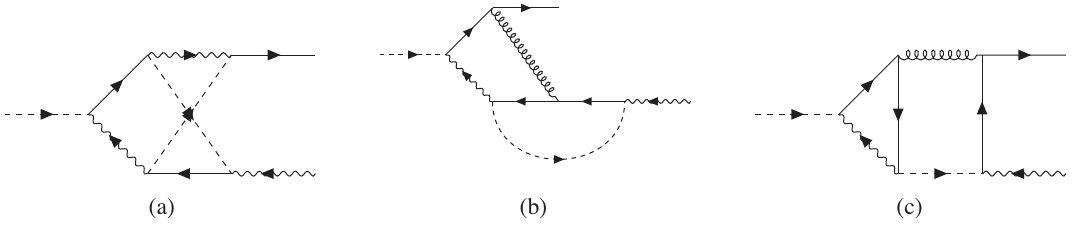
FIG. 12. Two-loop diagrams for vertex corrections to g 0 . In these diagrams, the solid line is for the f propagator, the dashed line is for the ψ propagator, the wavy line is for the b propagator, and the spiral is for the ϕ